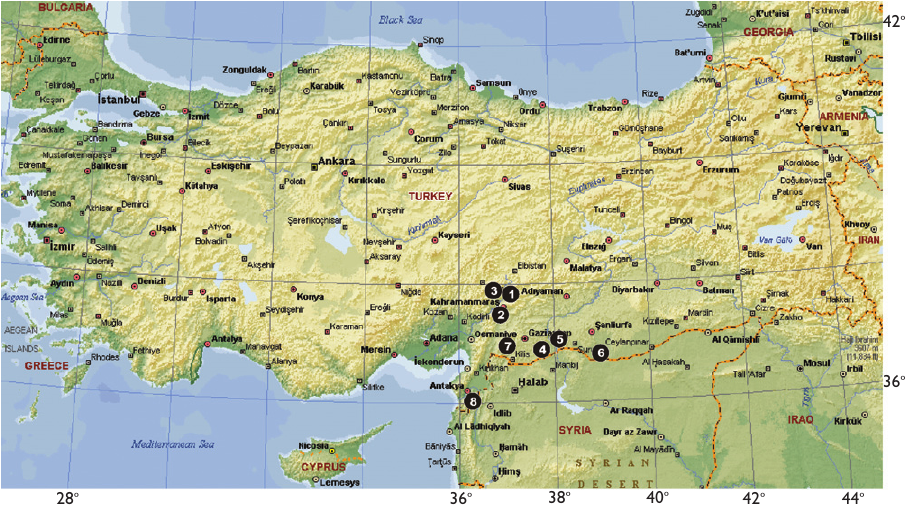
Figure 14. Distribution of Hersiliola turcica sp. n. Numbers correspond to localities on the